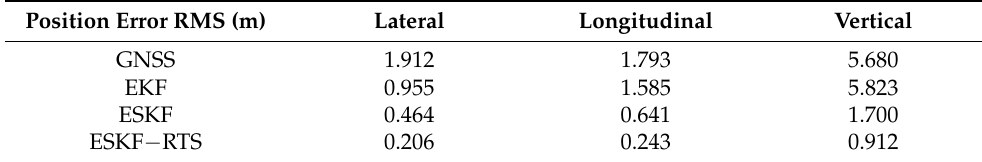
Table 3. RMS values of localization errors for different algorithms (Serpentine 1).